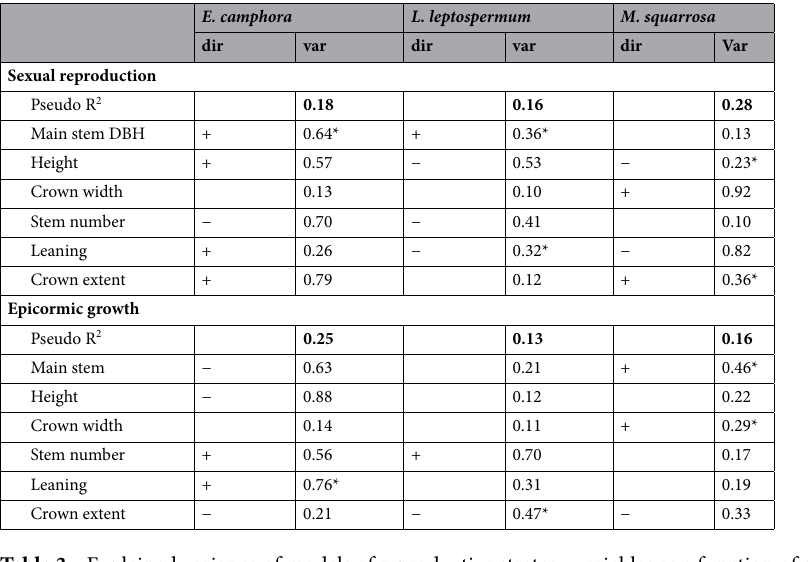
Table 3. Explained variance of models of reproductive strategy variables as a function of growth-form variables. Explained variance (in bold) is expressed as pseudo-R 2 . For each predictor variable, its proportional independent contribution is shown, and, if its total contribution to explained variance (i.e. proportion explained × R 2 ) > 0.05, the direction of the effect (dir) is indicated as positive, “+”, or negative, “−”. Variables that independently explained a larger proportion of variance than could be explained by chance are marked with an asterisk. Sample sizes were n = 111 for E. camphora , n = 76 for L. lanigerum and n = 77 for M. squarrosa . DBH diameter at breast height. Var proportion of explained variance (bold) and contribution to explained variance,